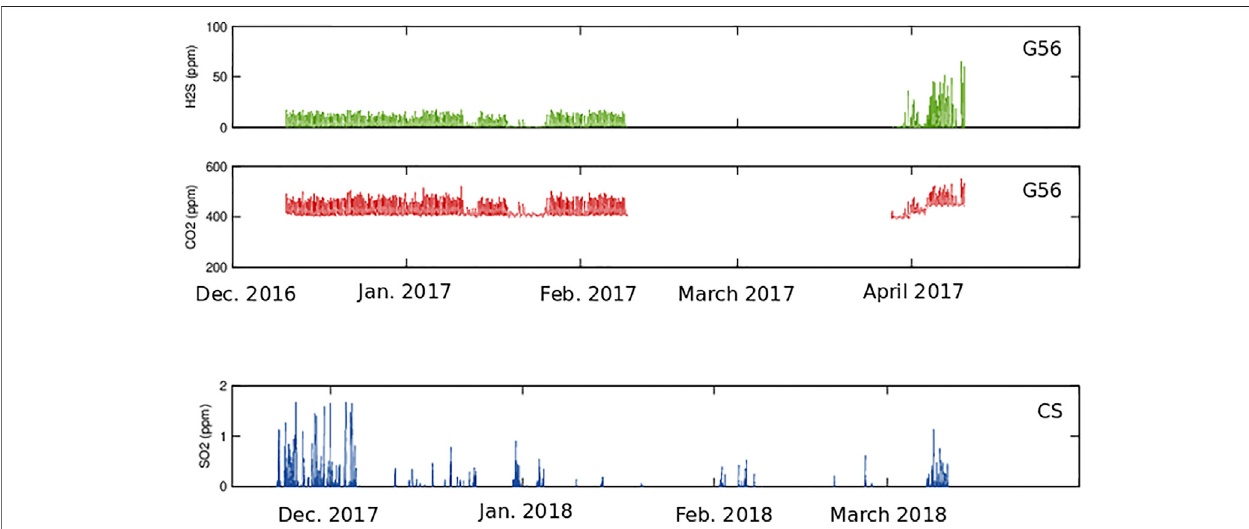
FIGURE5| InsetfocusingonSO 2 , H 2 SandCO 2 concentrationsoftheMultiGaspermanent stations during thetransitionbetween P1andP2(between December 01, 2016 and May 01, 2017), and during P2 (between November 15, 2017 and April 01, 2018) which encompasses the highest peak of activity on La Soufrière since 1976. Note that during P2, the H 2 S sensor of the permanent station at CS was